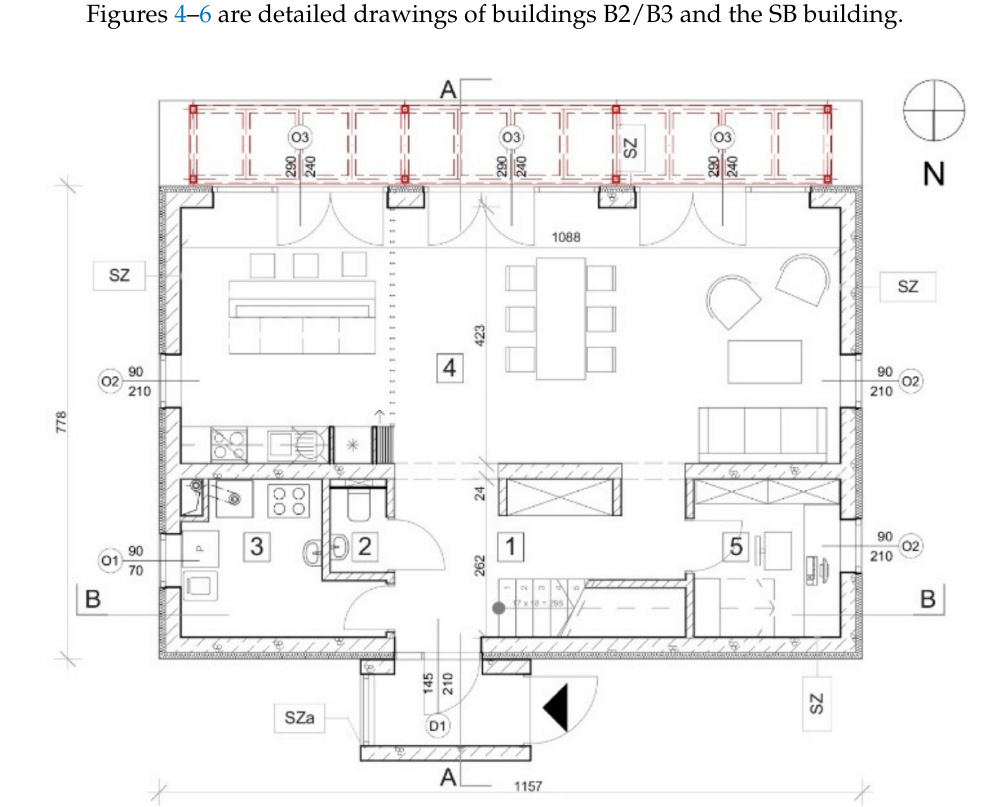
Figure 4. Model B2, B3. Ground floor plan. Scale of 1:100. The canopy used in model B2 is marked in red. Source: own study using ARCHICAD